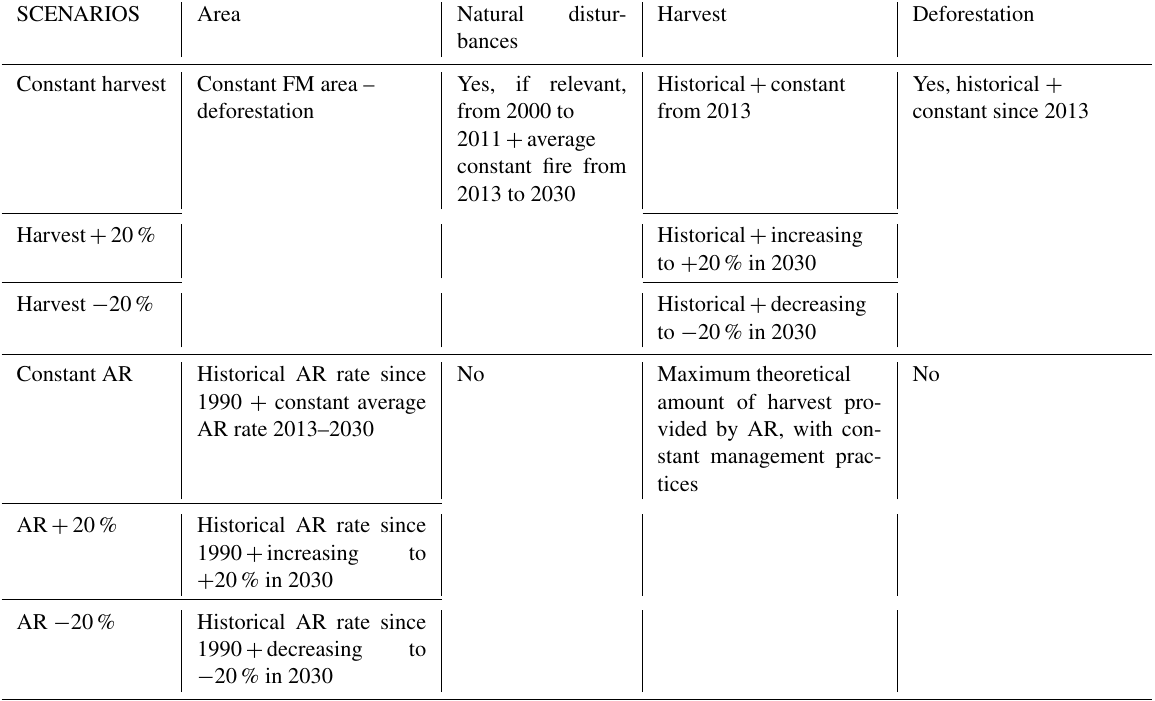
Table 2. Assumptions and main parameters for the model scenarios. FM: forest management area, i.e., area of the existing forests in 1990. AR: afforestation and reforestation that has occurred since 1990).